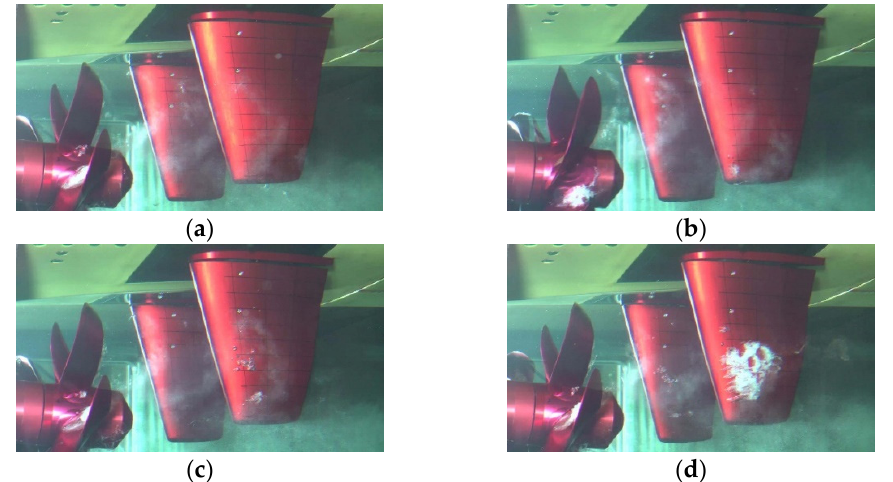
Figure 25. Cavitation observation of the asymmetry-type rudder with the variation of its deflection angle in the large cavitation tunnel (experiment). ( a ) 0°, ( b ) − 2°, ( c ) − 4°, and ( d ) − 8°.